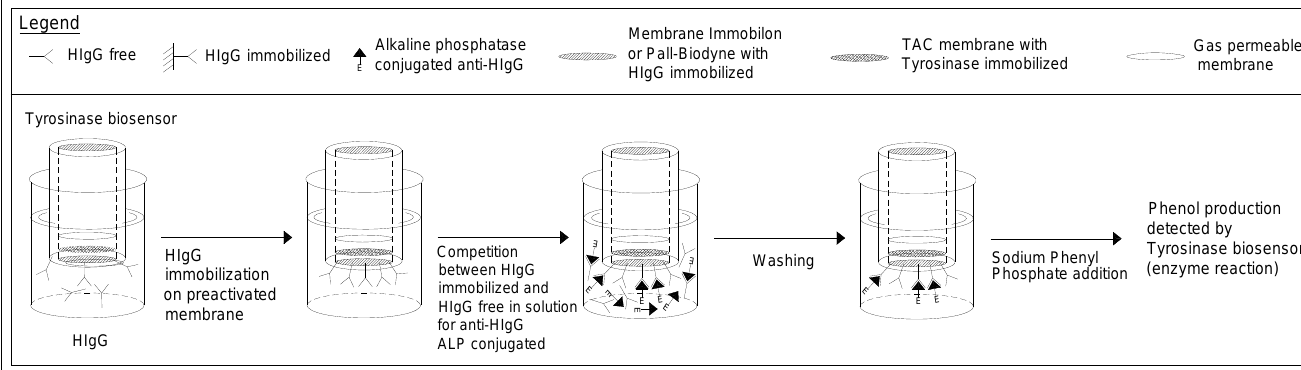
Figure 3. Determination of antigen (HIgG) by new immunosensor, using tyrosinase enzyme electrode as transducer. Test geometry: competition for anti-HIgG urease conjugated, between HIgG immobilized on membrane and HIgG free in